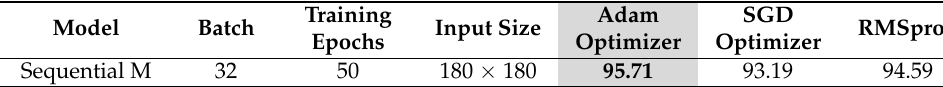
Table 2. Optimization algorithm vs. Classification Accuracy [%].